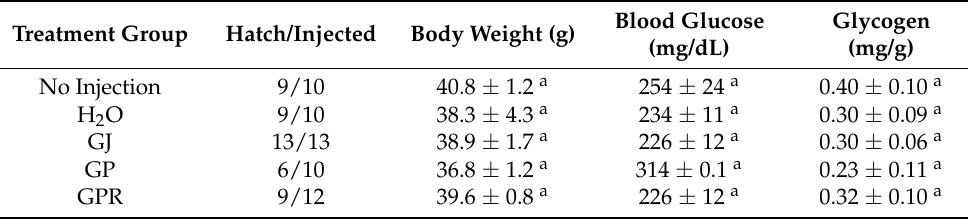
Table 3. Hatchability, body weight, blood glucose, and pectoral glycogen values. Treatment